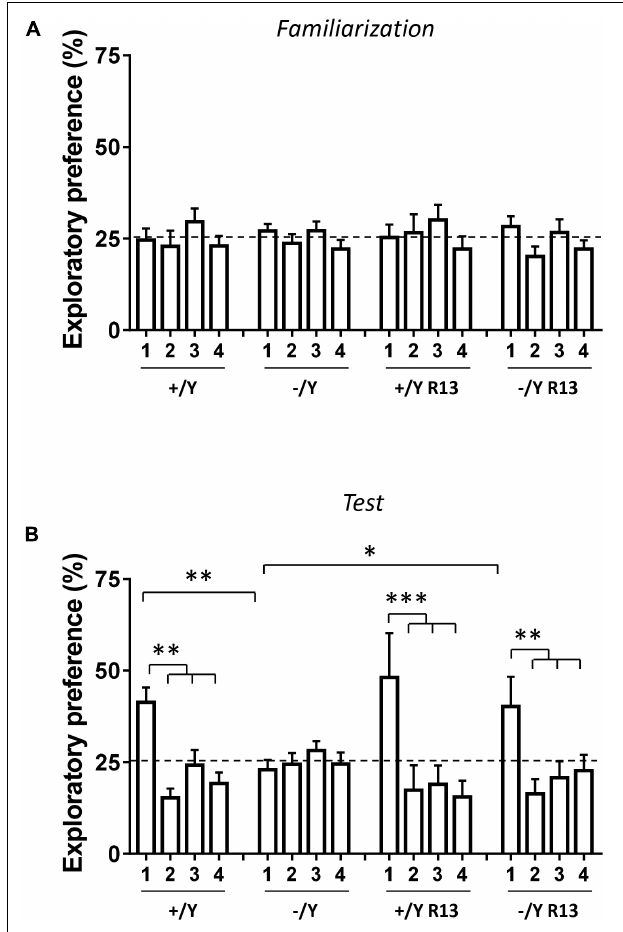
FIGURE 9 | Effect of treatment with R13 on novel object recognition memory in Cdkl5 -/Y mice. (A) Familiarization phase. Percentage of time spent exploring the four identical objects during the familiarization phase (10 min duration) of vehicle-treated Cdkl5 − /Y ( n = 13) and Cdkl5 +/Y ( n = 13) mice, and R13-treated Cdkl5 − /Y ( n = 9) and Cdkl5 +/Y ( n = 9) mice. (B) Exploratory Preference Test phase (one hour after the familiarization phase, 10 min duration). Percentage of time spent exploring new object 1 (that replaced the previous object 1) and the previous identical objects 2–4. Same mice as in (A) . Values represent mean ± SE. ∗ p < 0.05; ∗∗ p < 0.01; ∗∗∗ p < 0.001 (Fisher’s LSD test after two-way